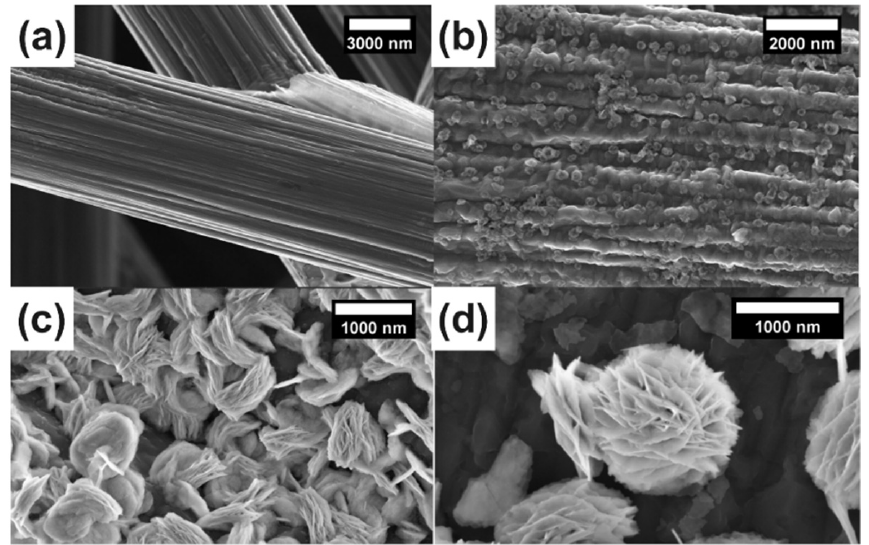
Figure 1. SEM images ( a – d ) of Bi/CP at different electrodeposition times: ( a ) rough carbon fiber; ( b ) Bi/CP 20 min; ( c ) Bi/CP 40 min; ( d ) Bismuth flower features of Bi/CP 60 min. The morphology of Bi 2 O 2 CO 3 @Bi/CP was similar to the multilayer flower-like Bi. As shown in Figure S3 and S5, some fuzzy streaks can clearly be seen on the SEM images of Bi 2 O 2 CO 3 @/Bi/CP, which is attributed to the decrease in conductivity. The reduction in electrical conductivity could be ascribed to introducing Bi 2 O 2 CO 3 into Bi/CP. X-ray diffraction (XRD) patterns are provided in Figure 2a to reveal the crystal types and changes of the samples. The (002) and (024) planes corresponding to graphite (JCPDS No. 01-0640) in all the samples are assigned to the CP. Furthermore, the crystalline structures of the as-prepared Bi/CP and Bi 2 O 2 CO 3 @Bi/CP achieved by exposing them to air are distinctly different. The peaks at 26.83, 37.65, 39.34, and 48.45 ◦ can be indexed to the (012), (104), (110), and (202) planes of the rhombohedral Bi (JCPDS No. 85-1329), respectively, and no other impurity peaks are observed. The intensive peak ~26.83 ◦ , which is attributed to the preferred orientation of the (012) plane, manifests the growth of flower-like Bi upon deposition. The spectrum of the sample exposed to the air presents the peaks at 23.83, 29.93, 32.40 and 45.22 ◦ , which corresponds to the (021), (023), (110) and (024) planes of Bi 2 O 2 CO 3 (JCPDS No. 411488). In addition, Figure 2a shows that a wide weak peak appears in the XRD patterns of the Bi 2 O 2 CO 3 @Bi/CP, implying the composite has converted to an amorphous phase. It could be demonstrated that a partial flower-like Bi was converted into Bi 2 O 2 CO 3 after exposing it to the air. According to previous studies, O 2 and CO 2 were freely chemi-absorbed on the bismuth surface in the air and led to the conversion reaction of Bi 2 O 2 CO 3 [33]. To obtain further details on the delicate structure of the Bi 2 O 2 CO 3 @Bi/CP, a high-resolution TEM image (Figure 2b) is shown and proves that there is a fragment of the lattice and the interface of Bi and Bi 2 O 2 CO 3 . The apparent lattice fringes in Figure 2b are measured at ~0.295 and ~0.328 nm, corresponding to the (012) plane of Bi 2 O 2 CO 3 and the (013) plane of Bi, respectively. Combined with the aforementioned SEM and XRD results, the existence of the transformed Bi 2 O 2 CO 3 and primal Bi could be verified in the Bi 2 O 2 CO 3 @Bi/CP, implying the conversion process of the Bi nanosheets to Bi 2 O 2 CO 3 on the